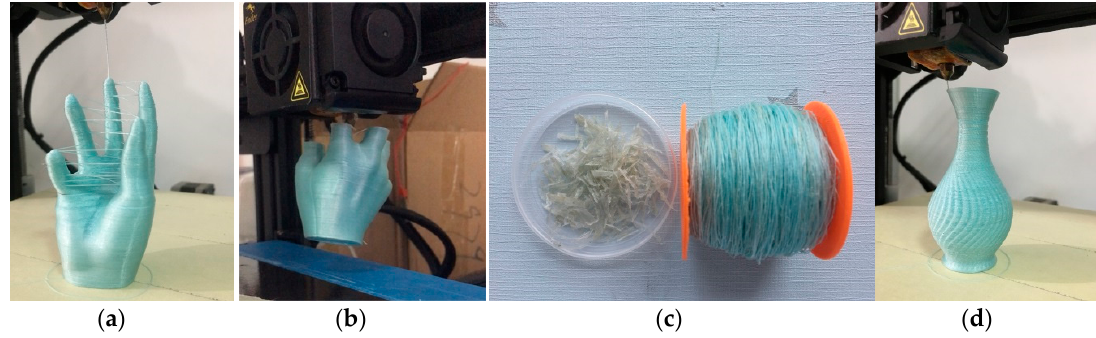
Figure 10. Recycling and remanufacturing. ( a ) Model printed with PFRTPCs. ( b ) Extracting materials with common FFF platform. ( c ) Recollected reinforced and matrix materials. ( d ) Remanufacturing after second prepregs.